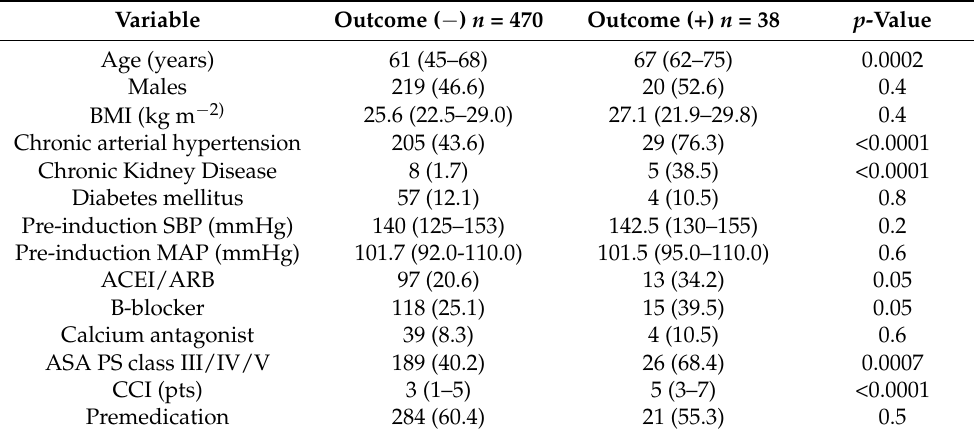
Table 1. Preoperative population